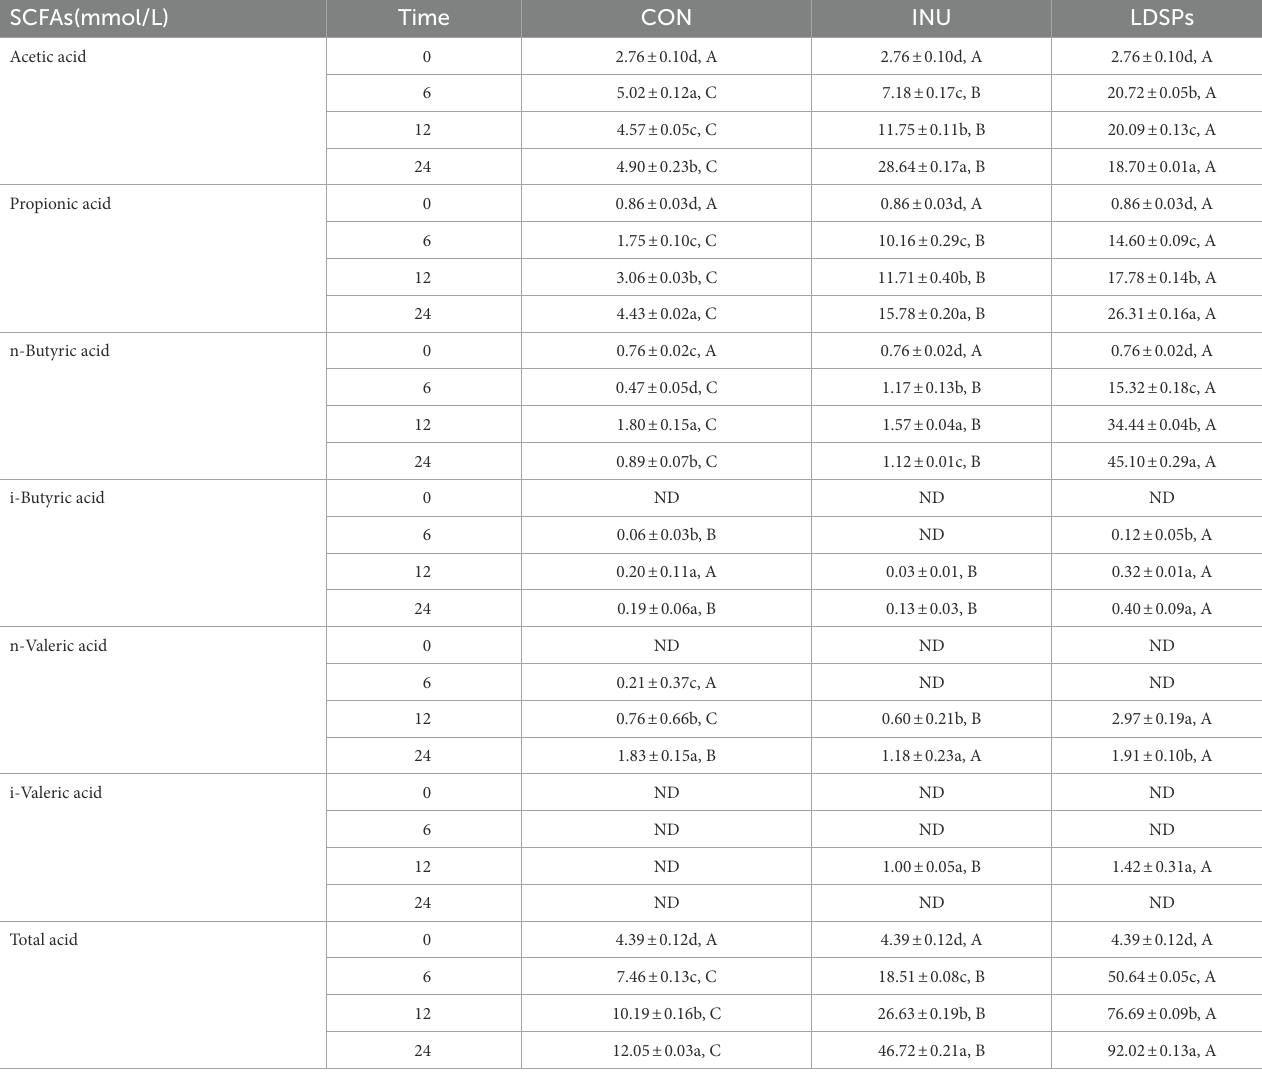
TABLE 4 Changes in SCFAs contents produced during